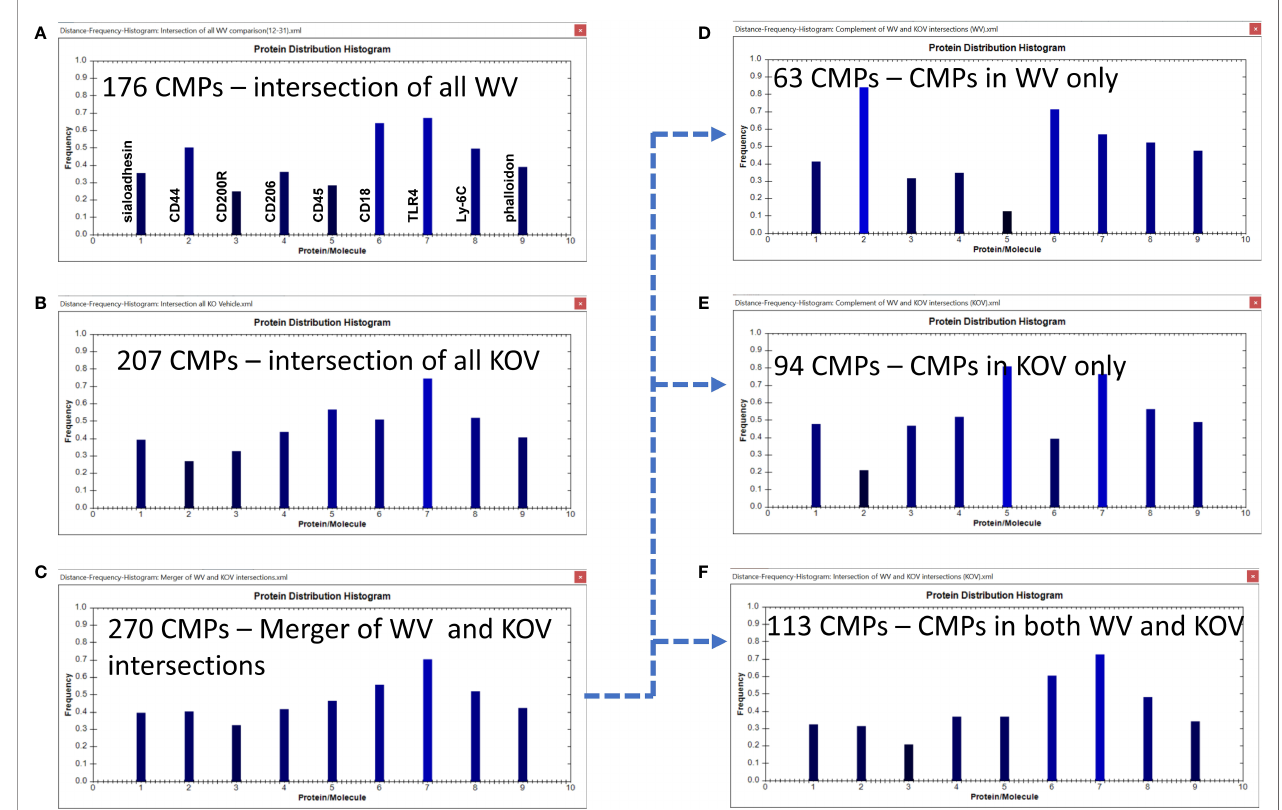
FIGURE 8 | CMP comparison of wild type vehicle (WV) and KO vehicle (KOV) samples. Panels (A, B) show the intersection of the three wild type vehicle and three KO vehicle samples. Panel (C) shows the results when the data in Panels (A, B) are merged and shows the characteristics of the 270 CMPs that are conserved in vehicle-treated WT and/or KO groups. Panels (D – F) use the complement feature of the TIS software to identify, from the 270 merged CMPs, CMPs present in wild type vehicle AM only (D) , KO vehicle AM only (E) , or common to both vehicle groups (F) . The arrow originating at Panel (C) and terminating at Panels, (D – F) illustrates this